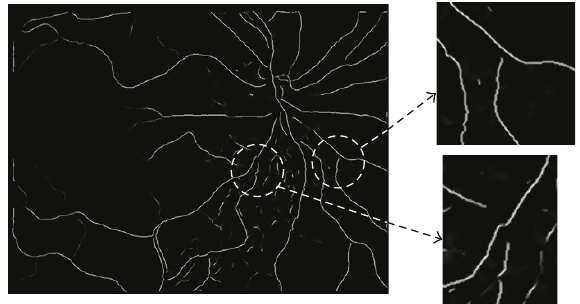
Figure 3: Example of discontinuities in the creases of the retinal vessels. Discontinuities in bifurcations and crossovers are due to two creases with di ff erent directions joining in the same region. Also, some other discontinuities along a vessel can happen due to illumination and contrast variations in the